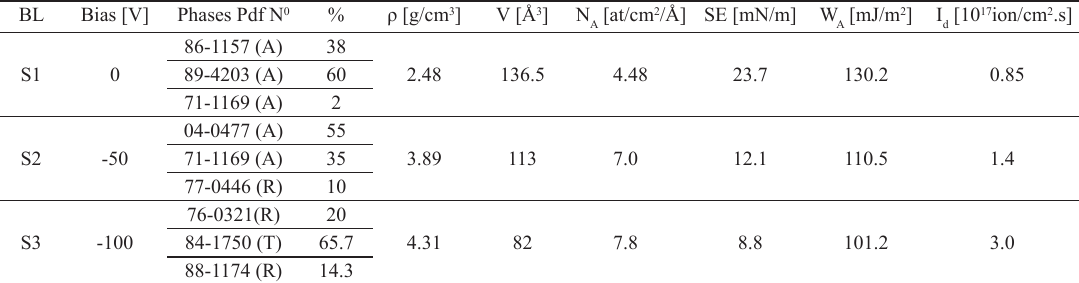
films deposited onto BL Figure 6. XRD spectra of porous TiO 2 (0V – M1; -50 V – M2; -100 V – M3)/FTO/Glass. Anatase only content - Ref. Pattern pdf N o Table 2. Blocking layers; A- Anatase; R -Rutile; T-tetragonal, the average mass density, volume cell, atomic mass, surface energies (polar components), work of adhesion (W